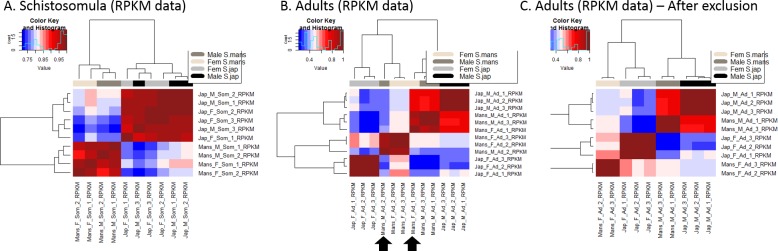
Correlation analysis between RNAseq libraries: heatmaps.